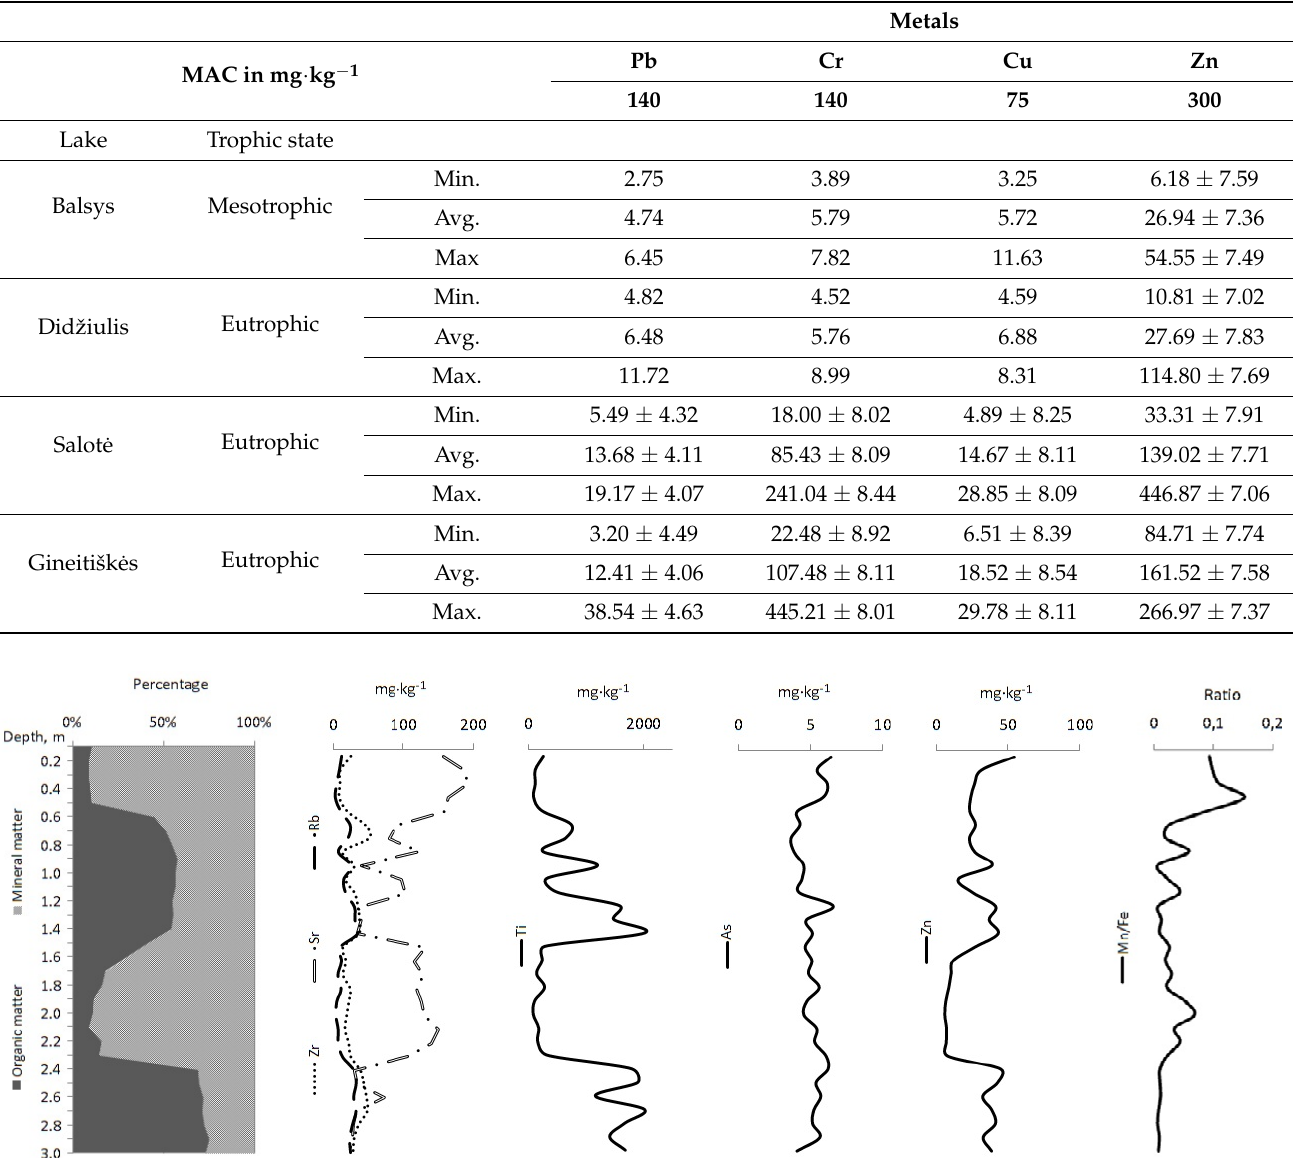
Table 1. The comparison of minimum, average and maximum values of Pb, Cr, Cu and Zn (mg · kg − 1 ) with maximum allowable concentrations (MAC) in bottom sediments of surface water bodies [32].